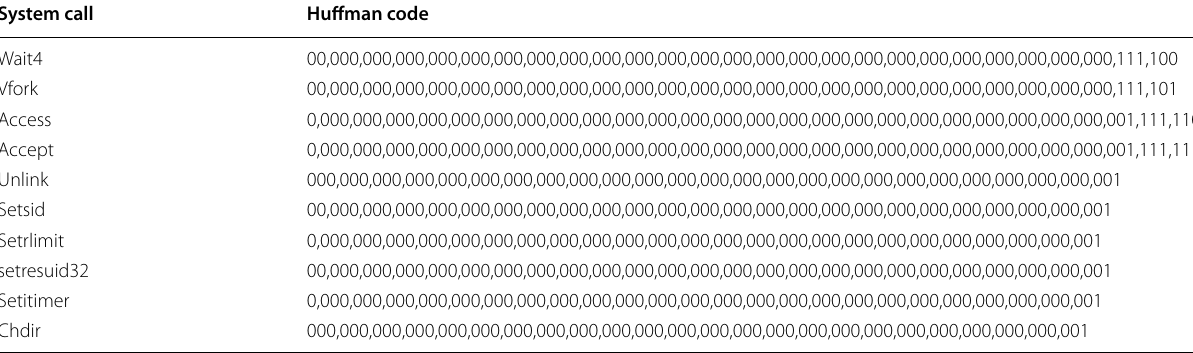
Table 3 Huffman codes of system call